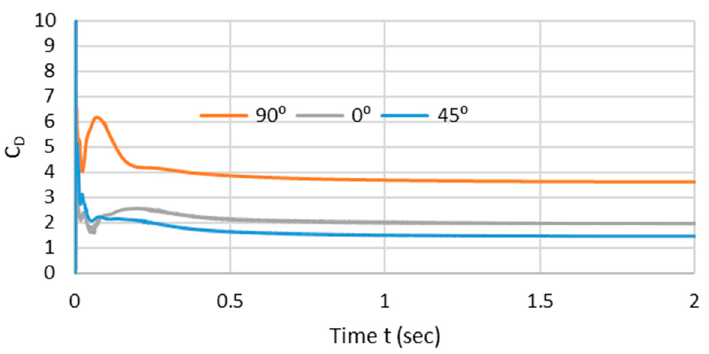
Figure 11. C D -comparison for different clamping positions.